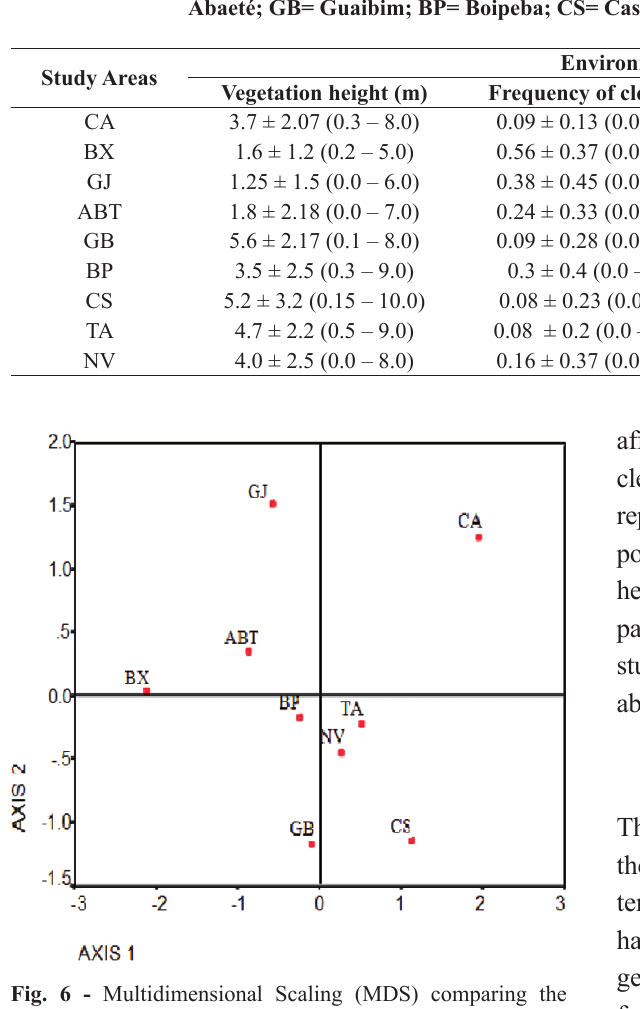
Mean, standad deviation (with range within parentheses) of vegetation height, frequency of clearings, bromeliads and palm trees of nine areas of restinga ecosystems studied along the coast of the State of Bahia : CA = Costa Azul; BX= Baixio; GJ= Guarajuba; ABT=